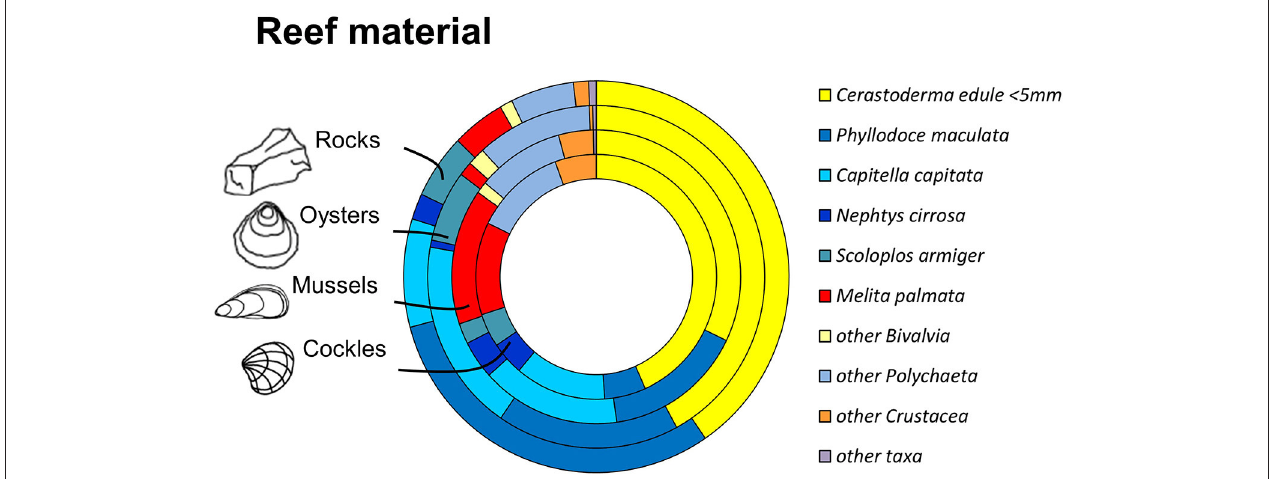
5), oysters ( n 6), mussels ( n 6), = = =